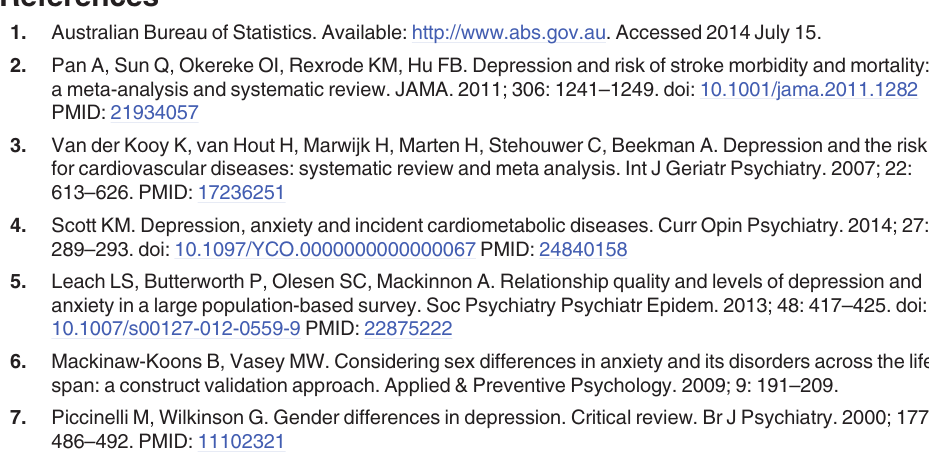
S1 Table. Correlation matrix representing associations between explanatory variables, me- diators and the outcome variable. (cid:1) p < 0.05, (cid:1)(cid:1)(cid:1) p < 0.001. PA = physical activity, MVPA = moderate-to-vigorous physical activity, QOL = quality of